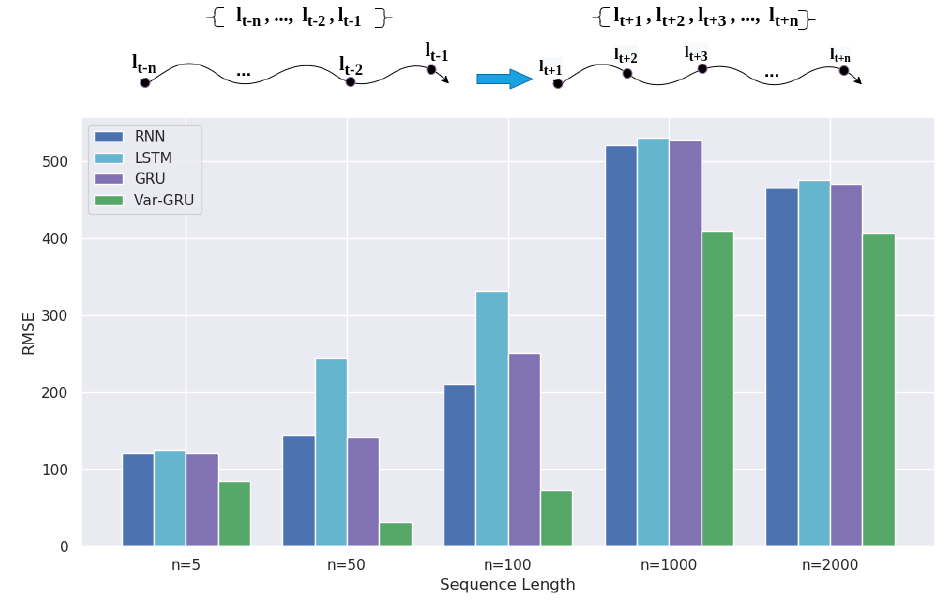
Figure 5. Impact of the sequence length on the prediction